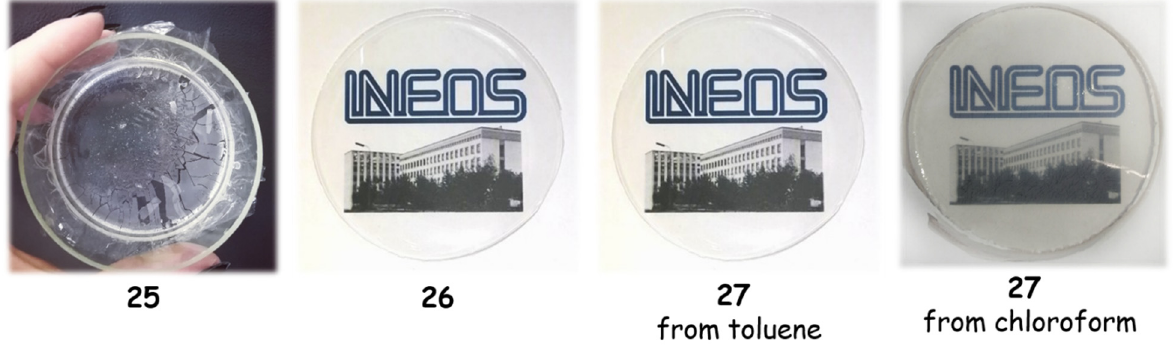
Figure 11. Polymer films 25 – 27.